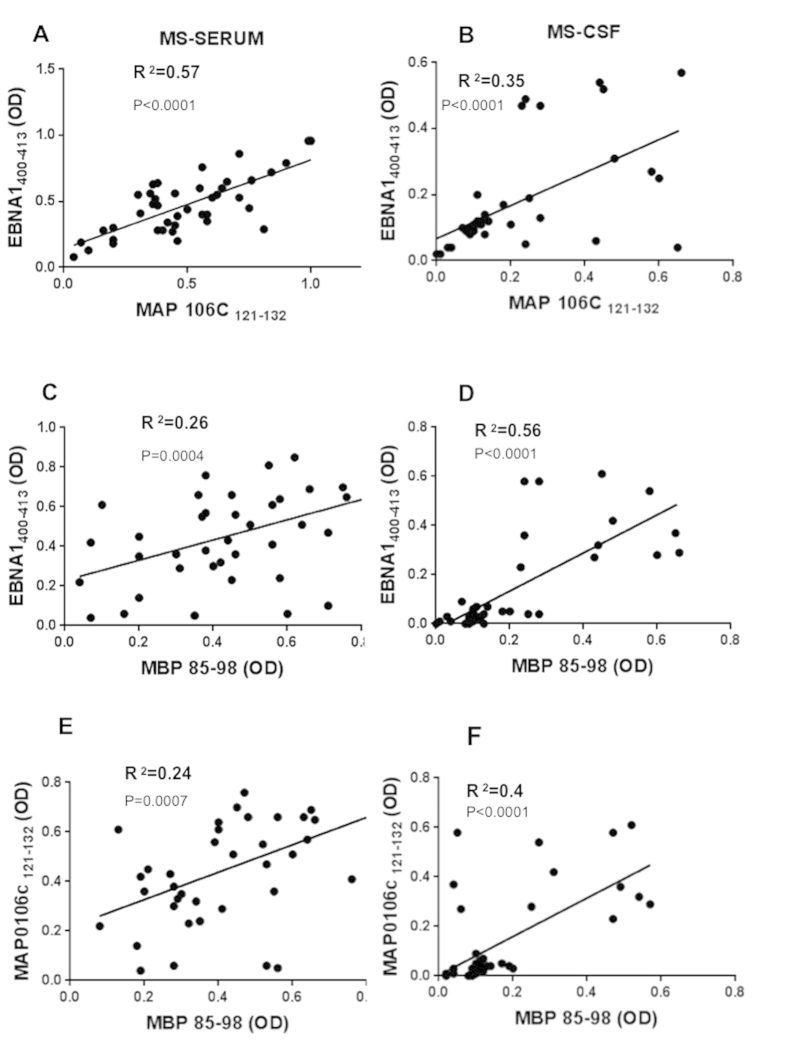
Scatter plot showing the correlations between EBNA1400–413 with MAP_0106c121–132 in serum (A) in CSF (B). EBNA1400–413 and MAP_0106c121–132 with MBP85–98 in serum (C,E) in CSF (D,F) in MS patients. Pearson’s correlation was calculated by Graph Pad 6.